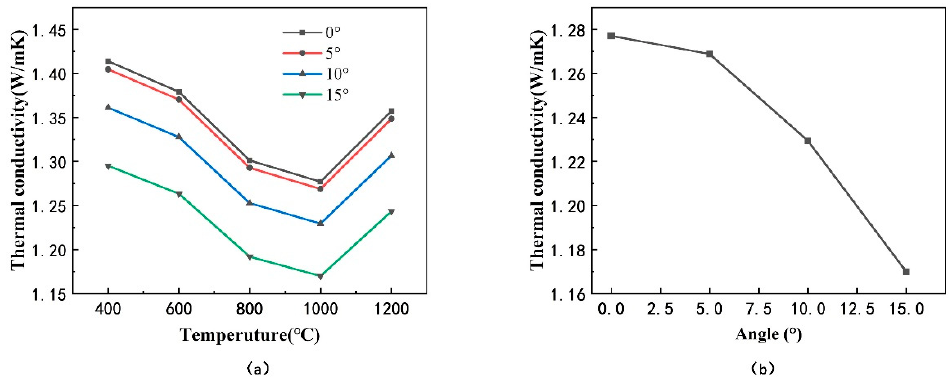
Figure 13. Effective thermal conductivity of models with different inclination angle α of the coating: ( a ) at different levels ( a ) at different levels of temperature, ( b ) at 1000 ◦ of temperature, ( b ) at 1000 °C.